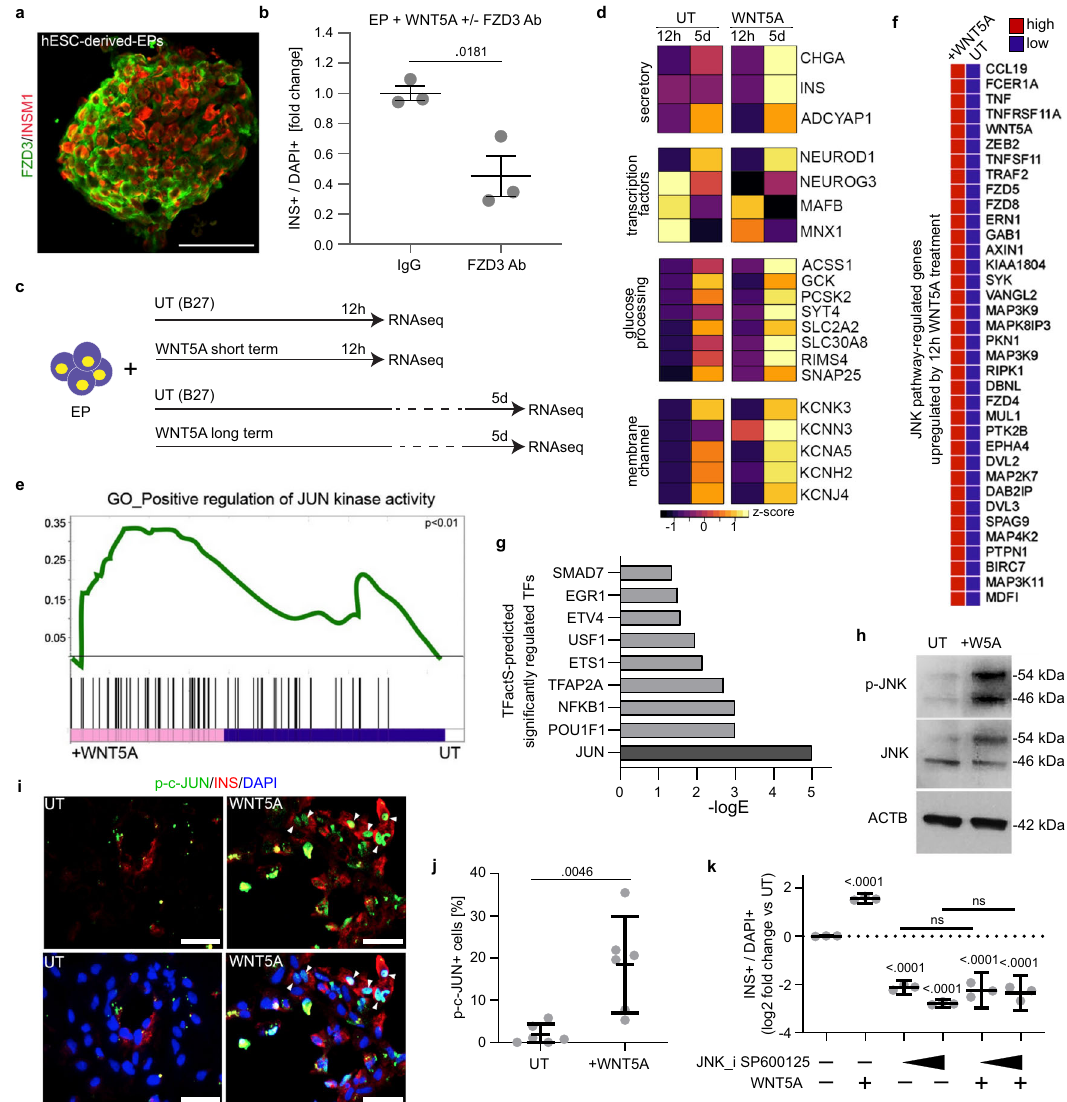
Fig. 6 Short-term WNT5A treatment activates the JNK/c-JUN pathway in human EPs. a hESC-derived EPs stained for FZD3 and INSM1. Scale bar = 50 µ m. N = 3 independent experiments. b Blocking FZD3 receptor in EPs leads to ~2.5-fold decrease in INS + cells compared to untreated control at day 3. Mean± SEM and a p value (unpaired two-tailed Student ’ s t test) are shown. N = 3 independent experiments. c Scheme to investigate by